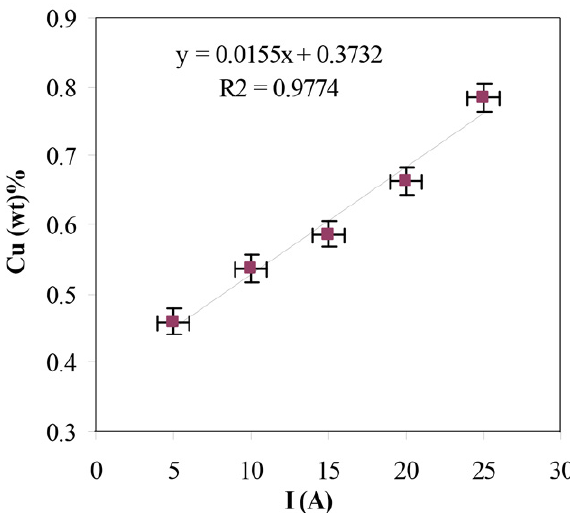
Figure 5. Effect of I on diffusion mean of copper in